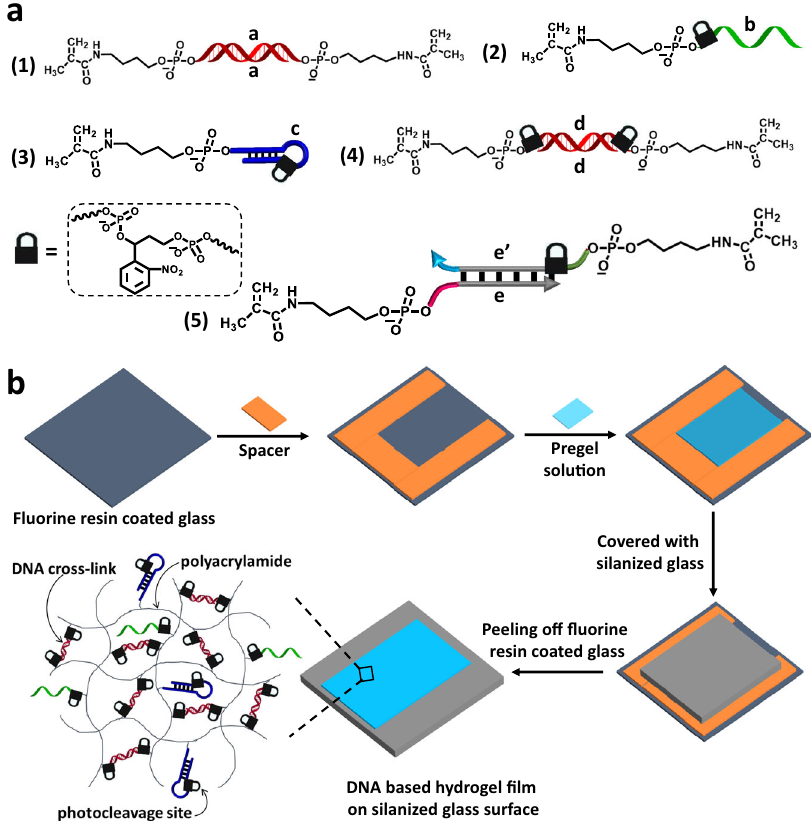
Fig. 1 Structures of the acrydite modi fi ed DNA strands used to construct the hydrogels and sequential steps to prepare the hydrogels. a Schematic structure composition comprising the photoresponsive o-nitrobenzylphosphate esters constituents that build the light-sensitive polyacrylamide hydrogels. Constituents to construct the diverse light-responsive hydrogels include: (1) Acrydite-modi fi ed self-complementary duplex (a)/(a). (2) Acrydite-modi fi ed ortho-nitrobenzylphosphate ester protected strand (b). (3) Acrydite-modi fi ed ortho-nitrobenzylphosphate ester protected hairpin (c). (4) Acrydite- functionalized ortho-nitrobenzylphosphate ester self-complementary duplex (d)/(d). (5) Acrydite-functionalized orthonitrobenzylphosphate ester modi fi ed complementary strands comprising the duplex (e)/(e ’ ). b Stepwise synthesis of the hydrogel fi lms that include the possible and variable acrydite- modi fi ed units (1)-(5) as possible components of the